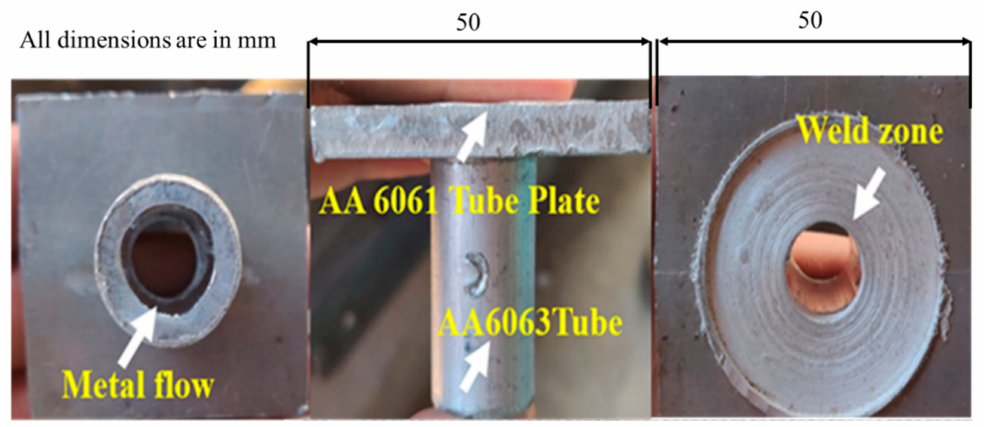
Figure 5. Pictorial view—welded joint of AA6061 (tube plate) and AA6063 (tube) using FWTPET + FSP